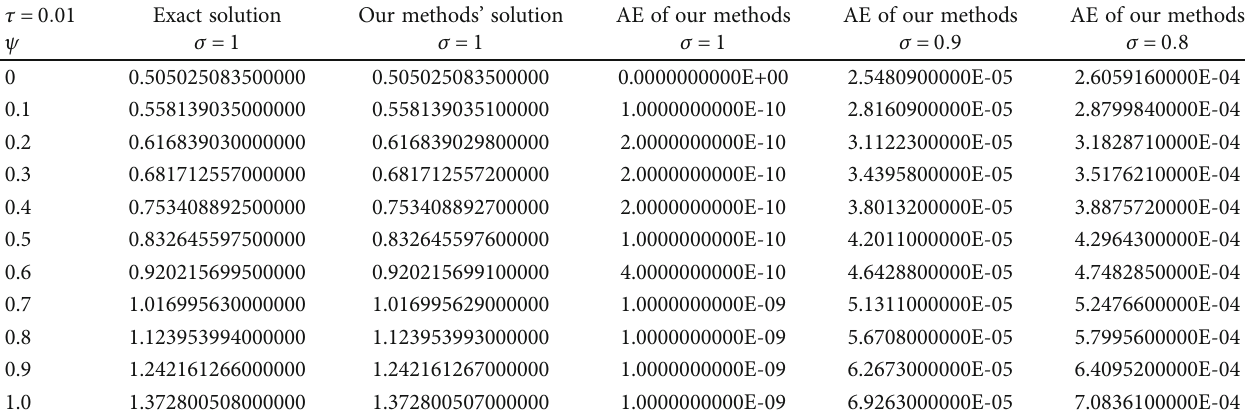
Table 2: ν ð ψ , ϕ , τ Þ comparison of exact solution, our methods ’ solution, and Absolute Error (AE) of Example 3. τ = 0 :